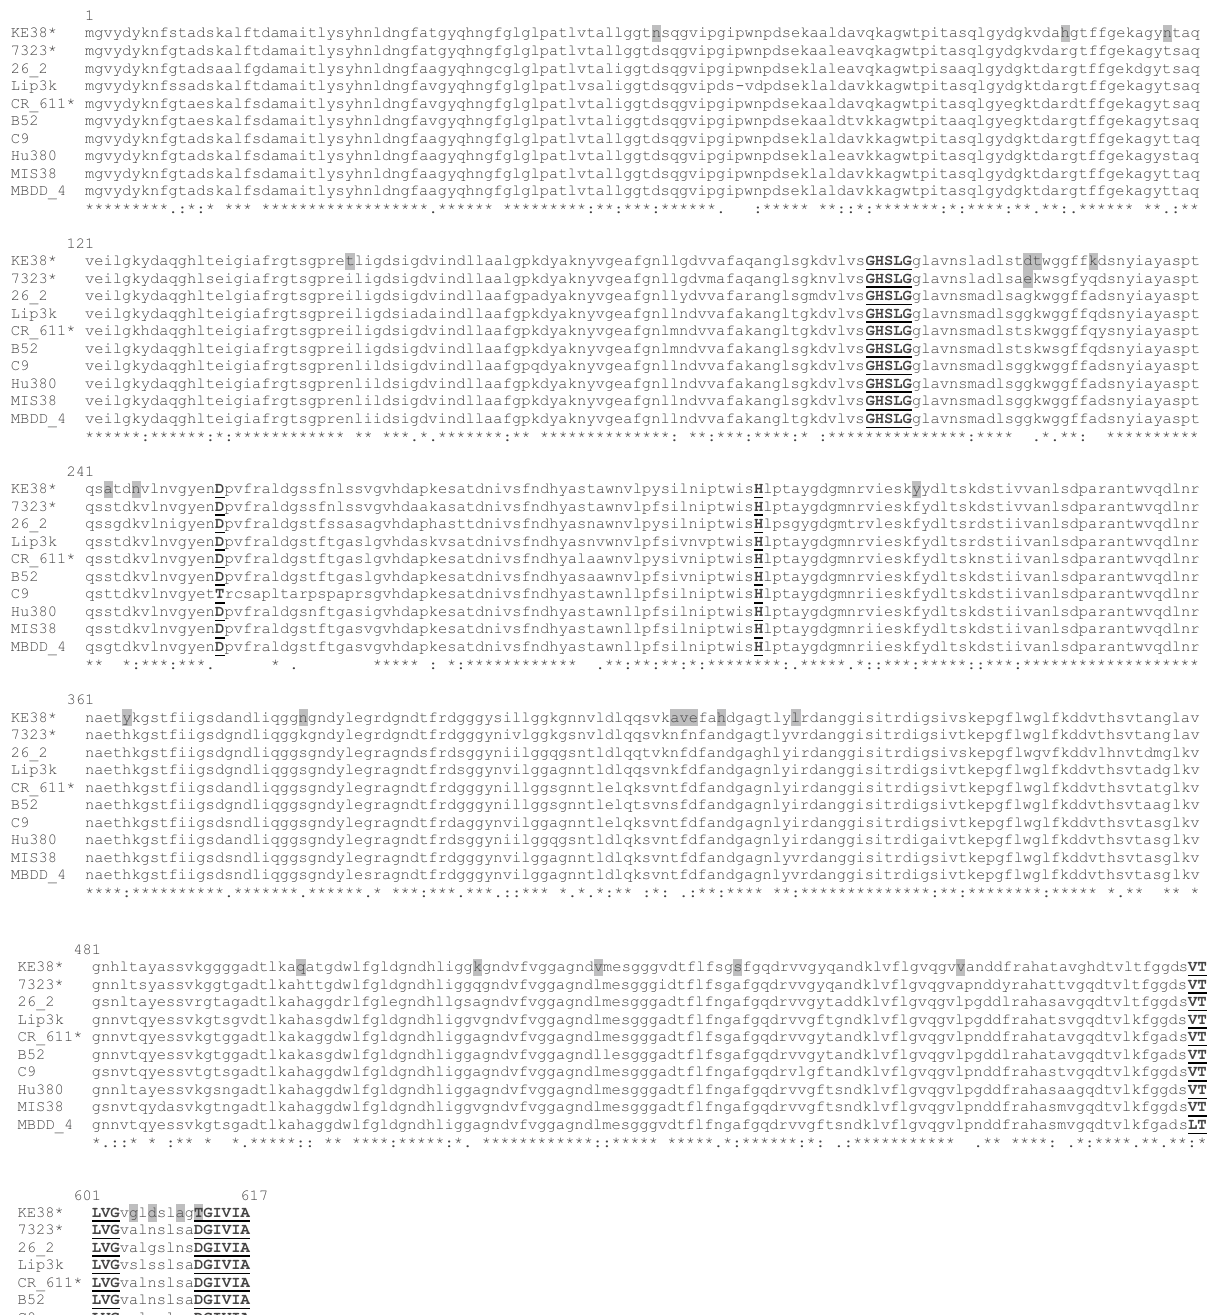
Figure 3. Alignment of the amino acid sequences of KE35TrueLip and closely related subfamily I.3 lipase enzymes from different bacteria. The accession numbers of the related lipase sequences are given in Table 1. Conserved motifs are shown in underlined bold capital letters, and amino acids unique to LipI.3_KE38 are shown in grey boxes. Cold active enzymes are indicated with “*” sign. The sequences were obtained from NCBI (http://www.ncbi.nlm.nih.gov/) and aligned by the Clustall Omega software (www.clust